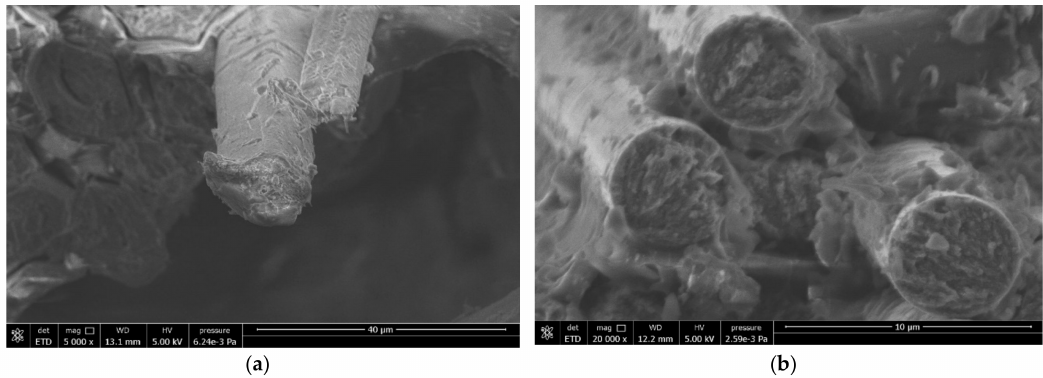
Figure 6. E-SEM images of fractured surface of ( a ) cross-sectional view of flax fibres and ( b ) carbon fibres.